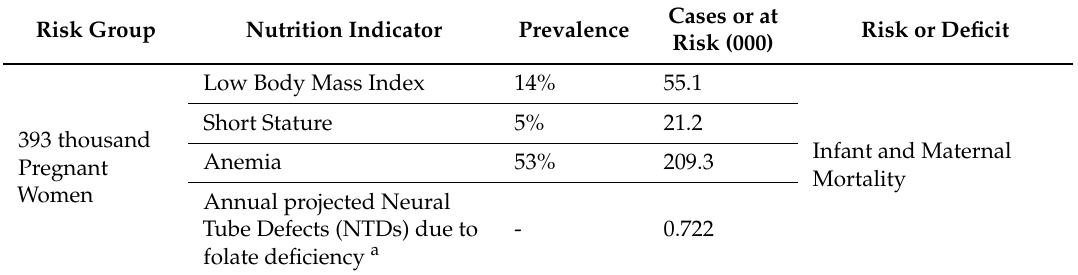
Table 1. Fourteen Nutrition Indicators: Cases and Risk Groups Derived from Demographic Health Survey 2014, Cambodia